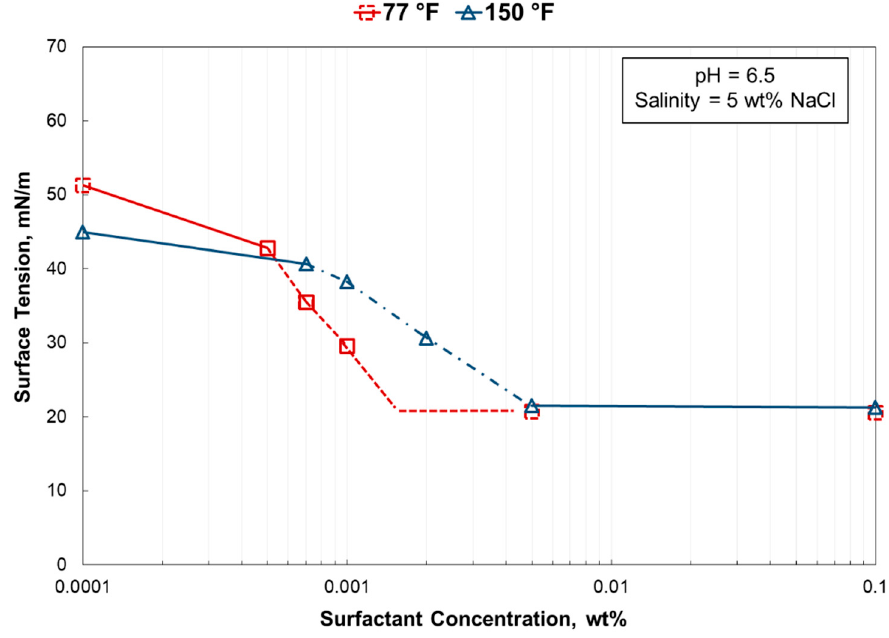
Figure 13. Effect of temperature on surfactant interfacial properties at pH 6.5 and 5 wt% NaCl.